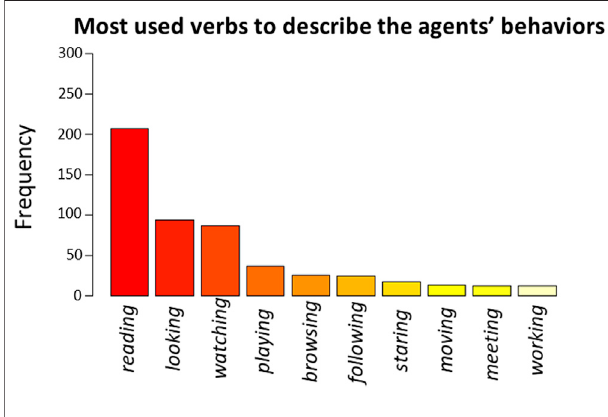
FIGURE 5 | Frequency plot of the ten most used verbs used by participants to describe the agents ’ behaviors.